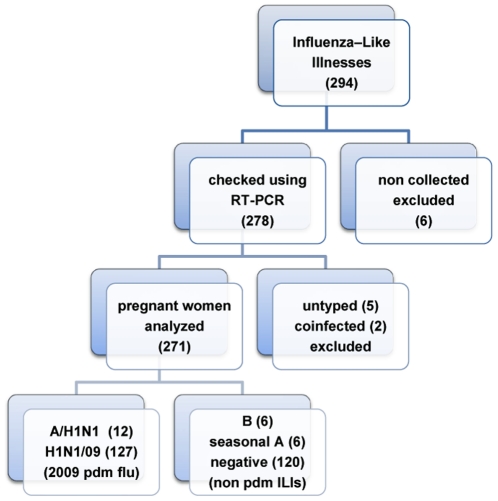
Flow chart of pregnant women with flu symptoms, maternity department, Saint-Pierre, Reunion Island, 2009.